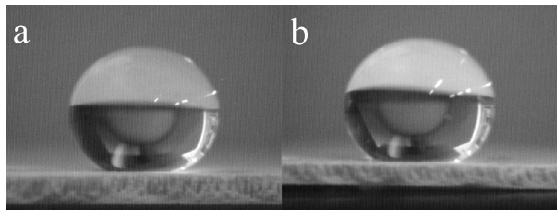
Fig. 4 Water contact angles after the modification: (a) M1; (b) M2.